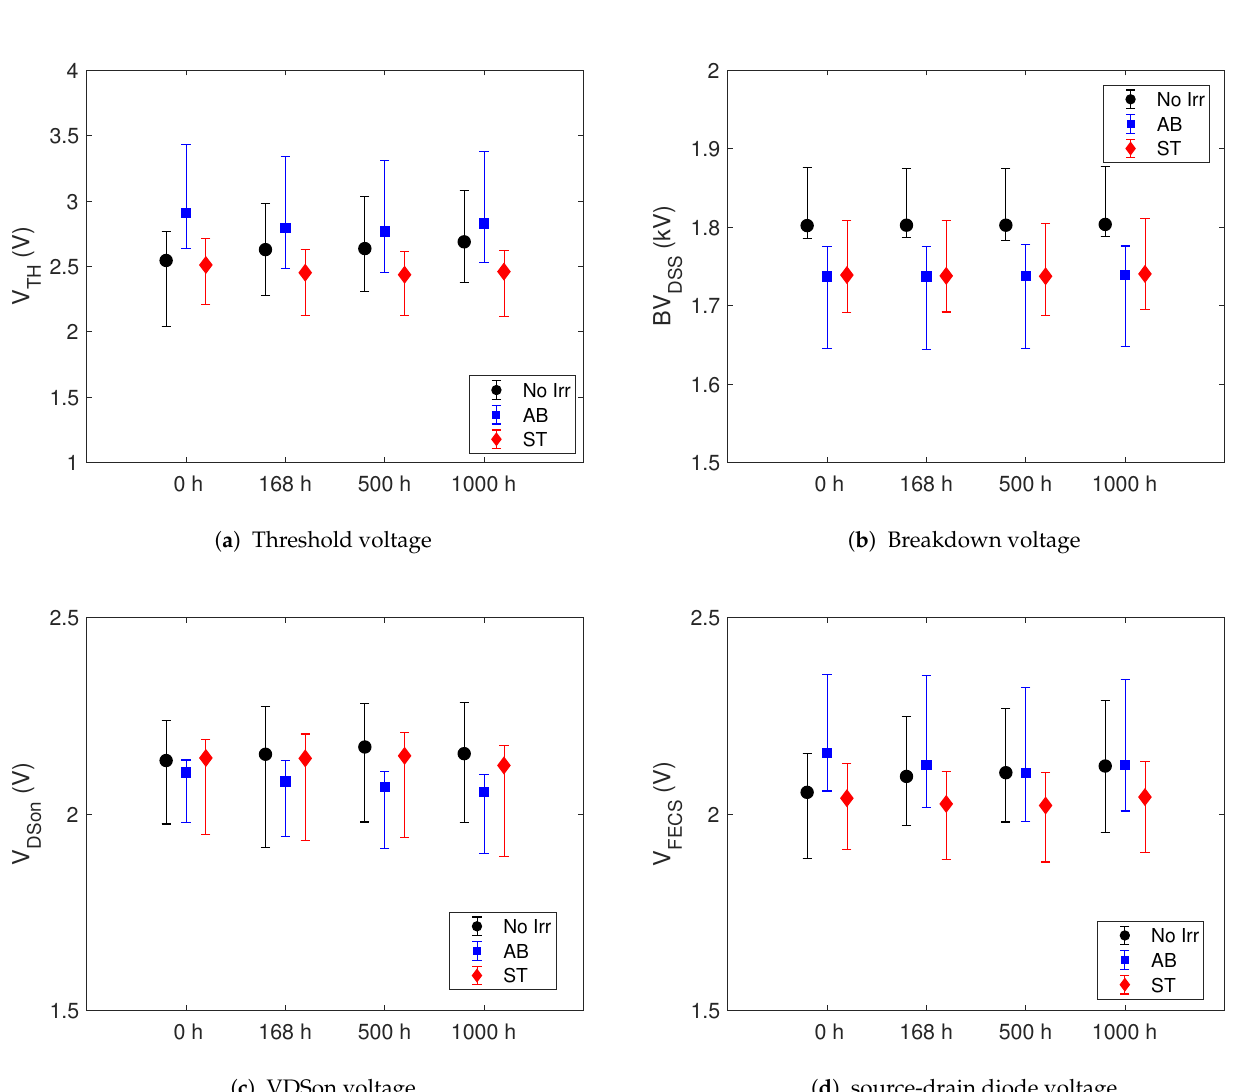
Figure 3. Shift of the median of some electrical parameters during HTRB stress of GEN3 SiC MOSFETs. The error bars indicate the minimum and maximum